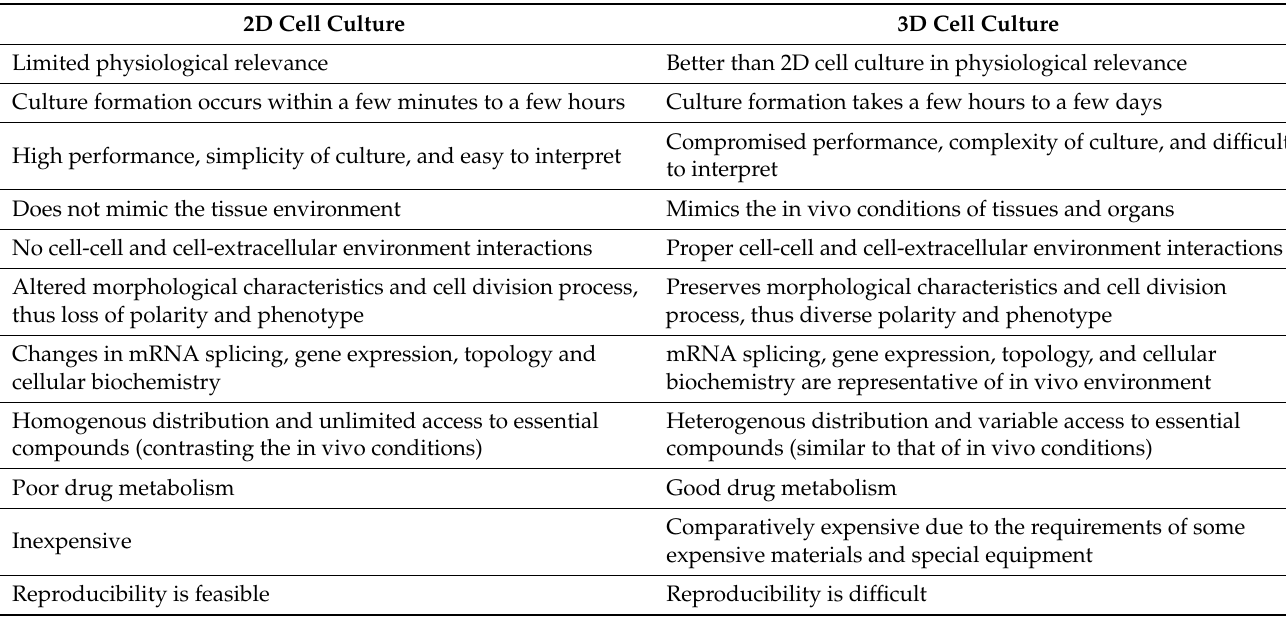
Table 1. A comparison of 2D cell culture and 3D cell